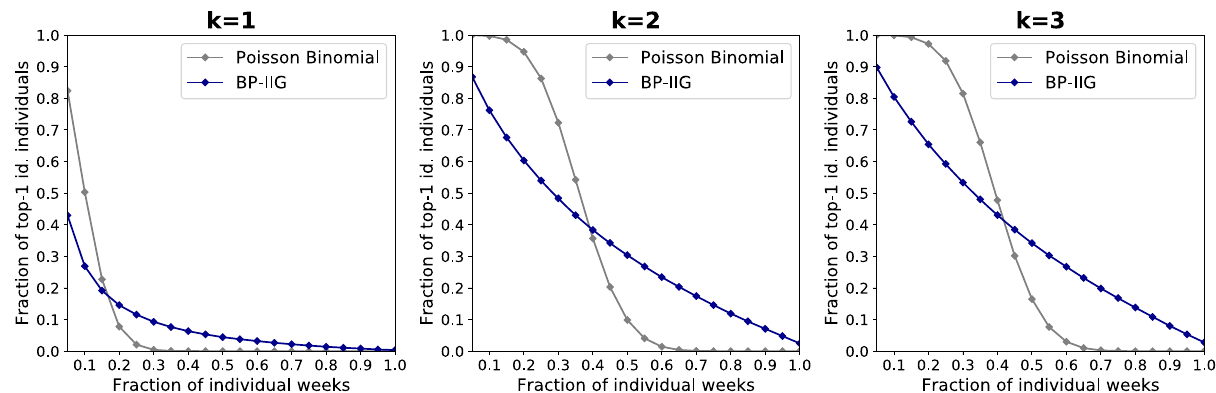
Fig. 5 Fraction of identi fi ed people vs. fraction of individual weeks. For each k ∈ {1, 2, 3}, we plot the fraction of people that are identi fi ed in at least a given fraction of individual weeks, using our model (in blue) and according to a Poisson binomial distribution (in gray, averaged over 100 trials). Our attack